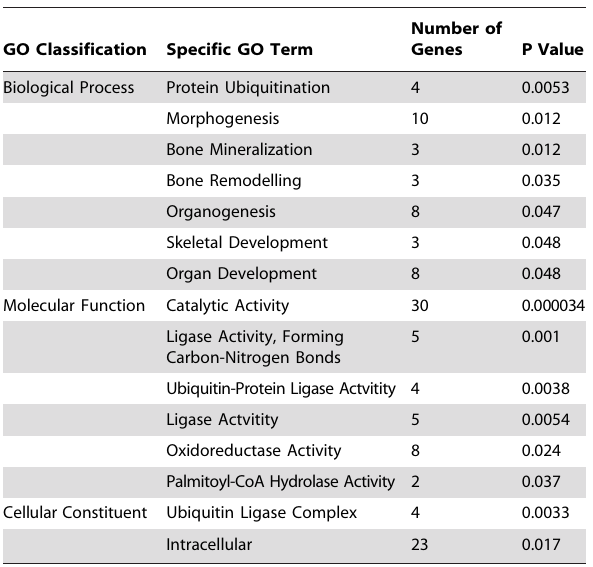
Table 1. Gene ontology groups with significant over- representation among genes with $ 2-fold increased expression in diabetic.